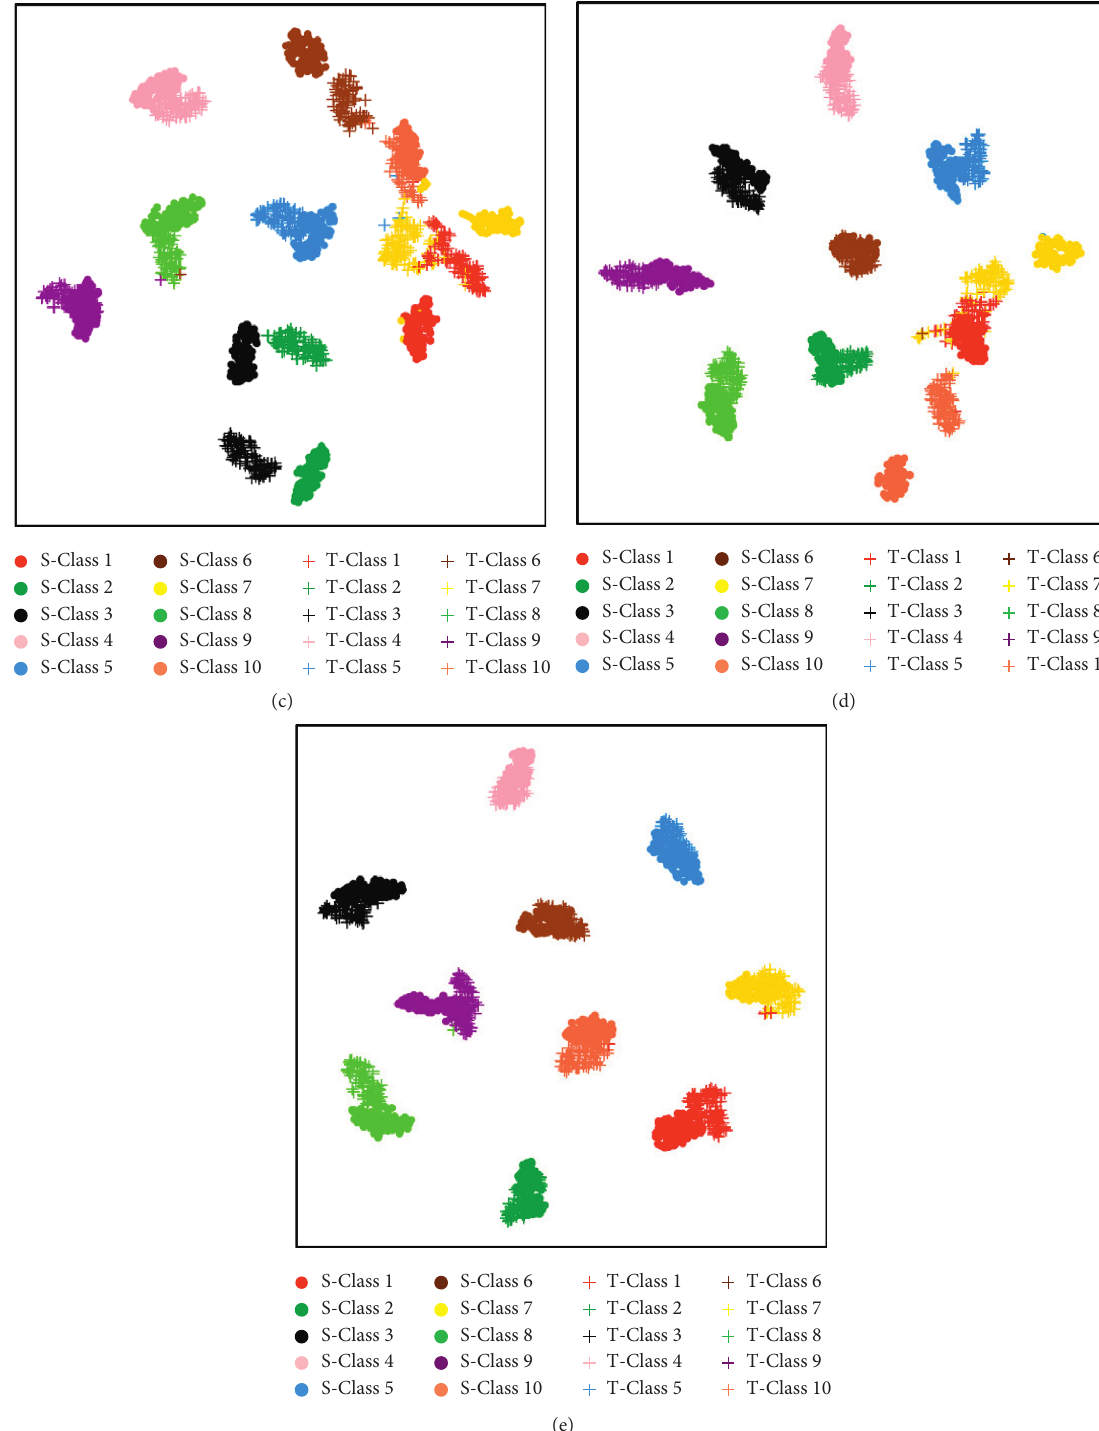
Figure 6: The t-SNE visualization of two domains in last layer features by five different methods in the task N1 ⟶ N2. Ten colors represent ten health conditions, S and Tdenote the classes in the source domain data and target domain data, respectively, and the five network models are (a) CNN, (b) TCA, (c) DDC, (d) DCDAN-WDC, and (e)